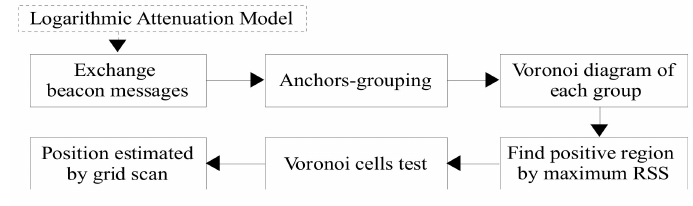
Figure 4. Schematic diagram of